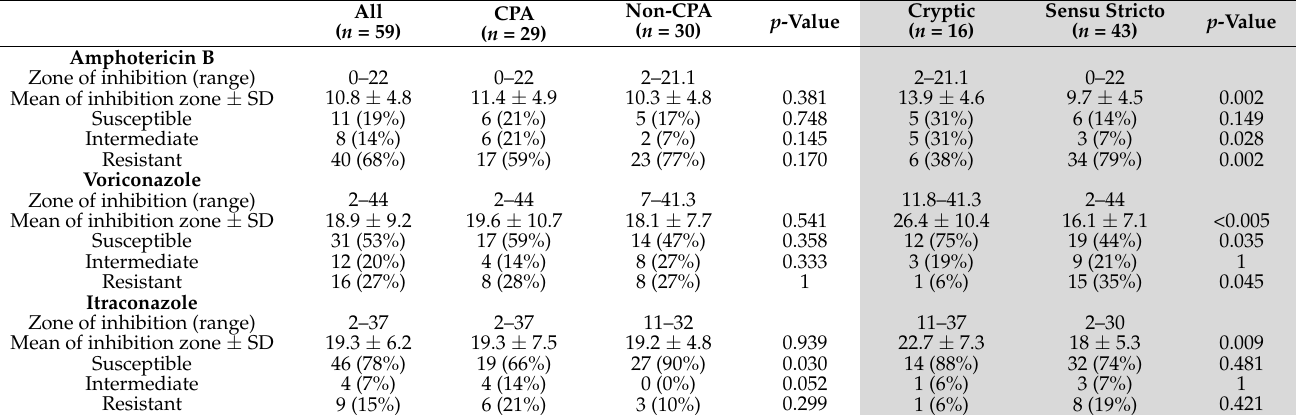
Table 3. Antifungal susceptibility profiles of Aspergillus isolates using disk diffusion